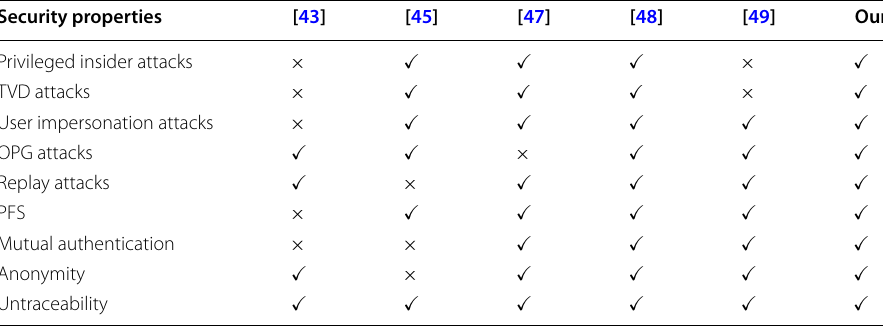
Table 4 The comparison of security Security